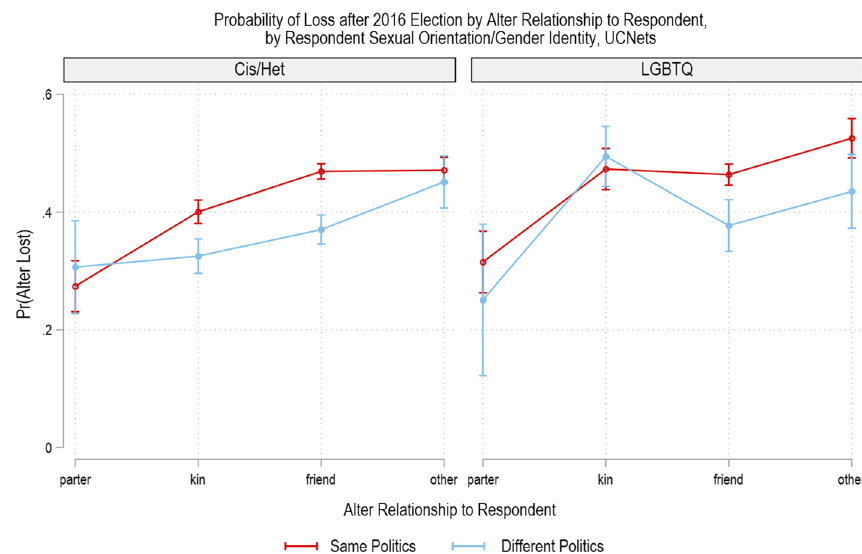
Fig. 2 Probability of loss after 2016 election by alter relationship to respondent, by respondent sexual orientation/gender identity,